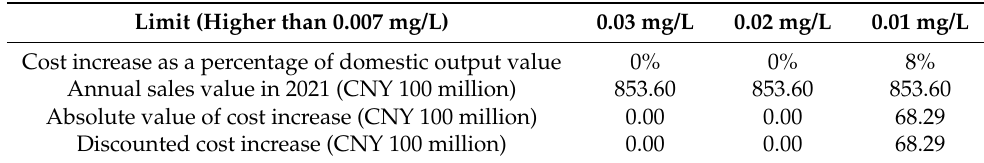
Table 5. Fixed asset investment expenditure due to the limit change.